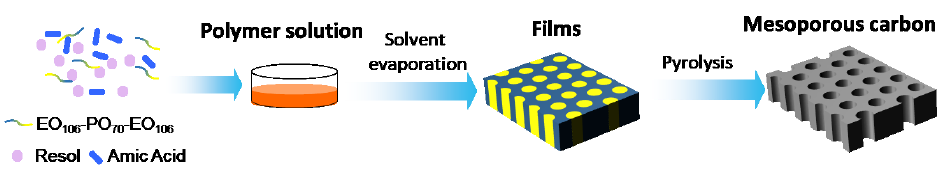
Figure 11. Schematic of the fabrication of mesoporous carbon via block copolymer-templated carbonization.